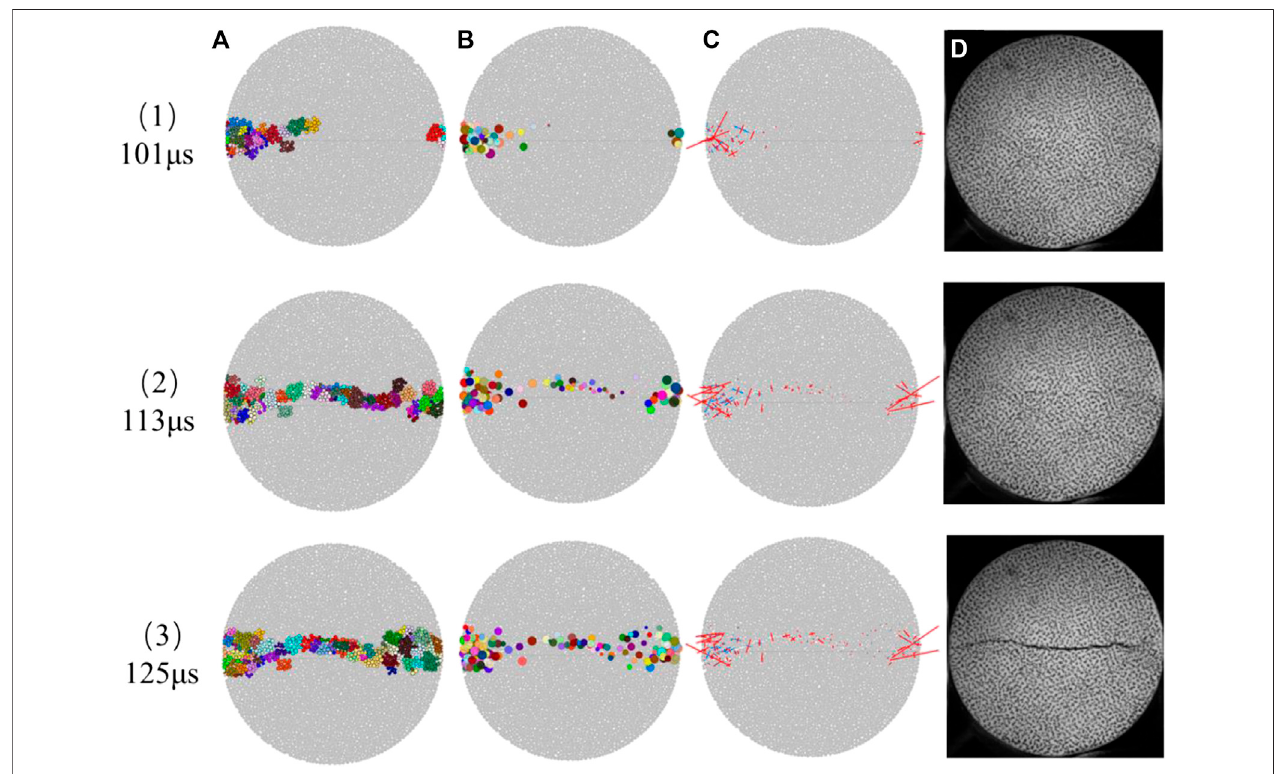
FIGURE8| TheresultsofAElocation,momenttensorinsimulation,andHSphotographybeforeandaftertheaxialmacro-crackgenerated. (A) istheAElocationat different moments; (B) isthe AEnormalization diagram withthe initial generatingposition ofeach AE event asthe center ofthe circle and theAE energy level value asthe radius; (C) is the results of the moment tensor; (D) is the results of high speed photographs in the dynamic tensile